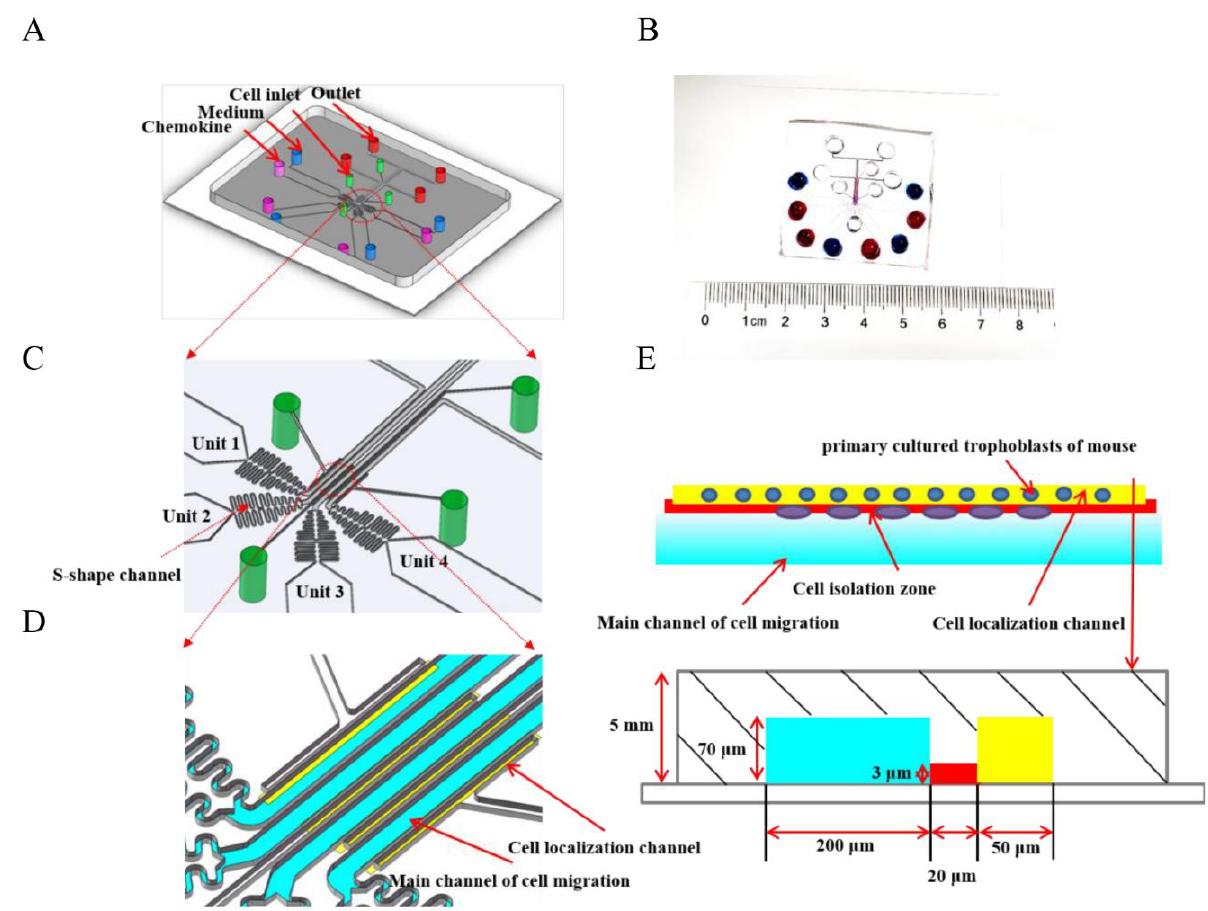
Figure 1. Illustration of the microfluidic D 4 -Chip device. ( A , C ) A schematic illustration of the fourth docking microfluidic device containing four units. Every unit is made of a cell inlet, outlet, and a dosing inlet containing medium and chemokine. ( B ) Soft-lithography adheres to the glass plate, and the dosing inlets are added to the ink. Blue ink represents medium and red ink represents chemokine. Moreover, both of them form the concentration gradient of chemokine in the main channel of cell migration. ( D ) From the image of the four microfluidic channels, cells are aligned beside in cell localization channel, and the formation of a concentration gradient in the main channel of cell migration owes to adding medium and chemokine at the same time. ( E ) I The length of the main channel of cell migration (Brillant blue), cell isolation zone (Red), and cell localization channel (Yellow) are 200 µ m, 20 µ m and 50 µ m, respectively. What is more, illustration of the microfluidic migration assay simply involves cell seeding and solution loading followed by incubation and final end-point imaging analysis.